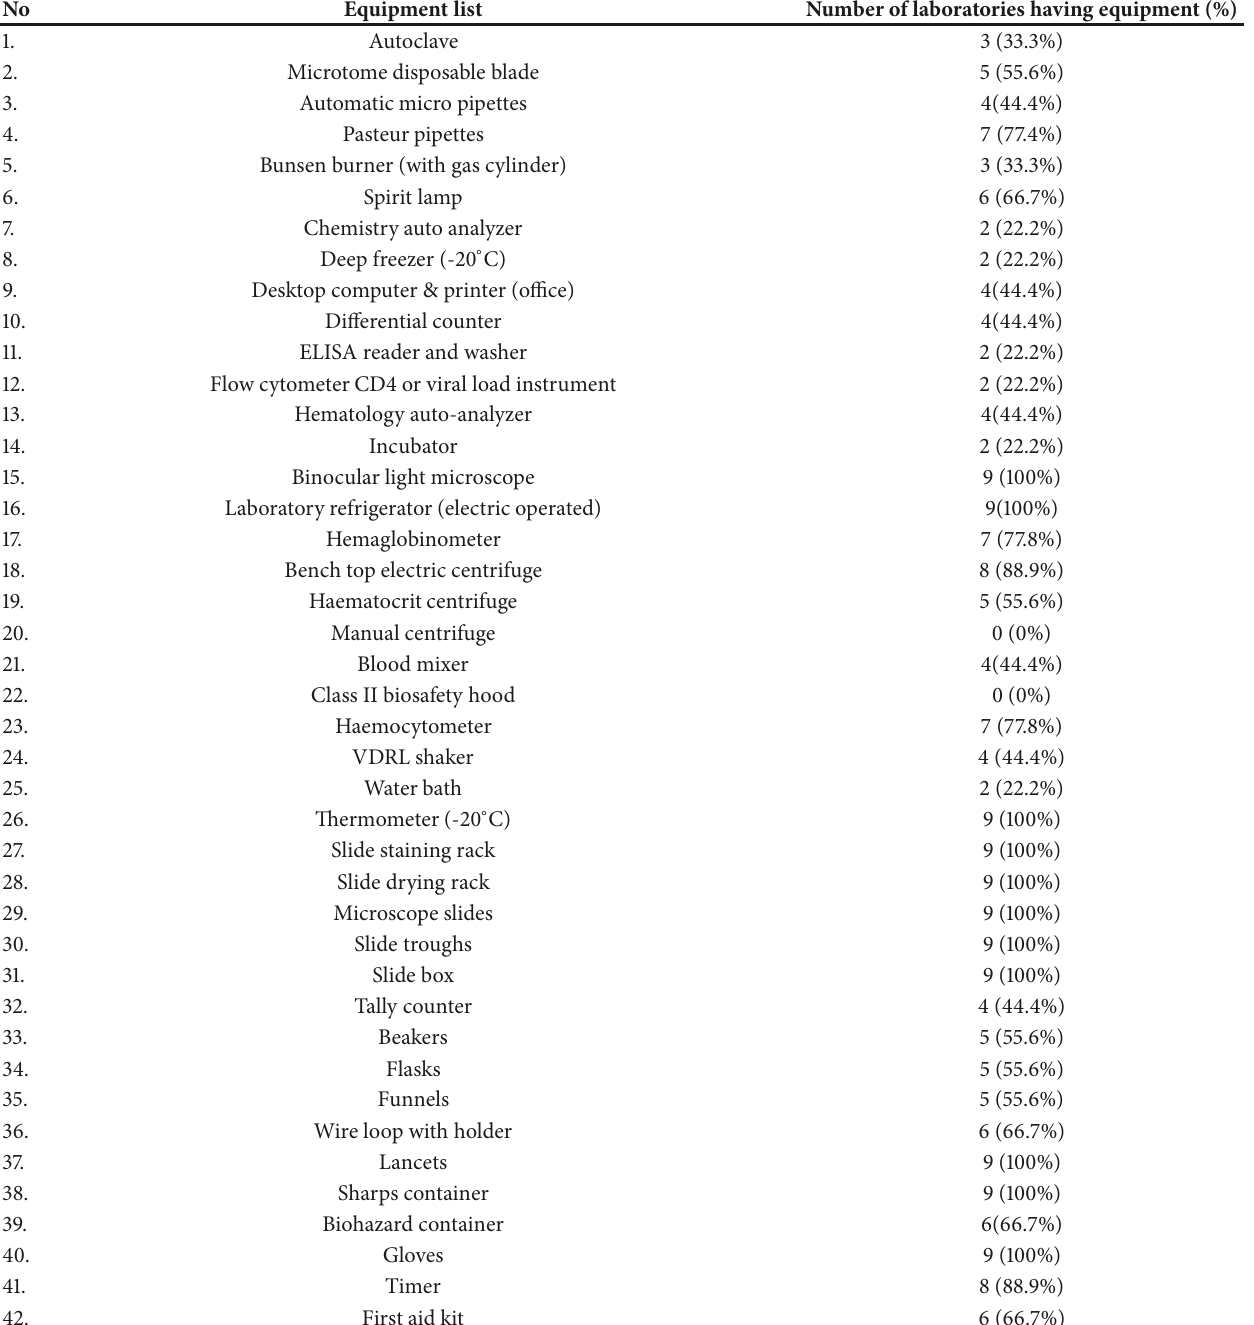
Table 1: List of laboratory equipment and materials found in zone one governmental health facility laboratories of Afar region,